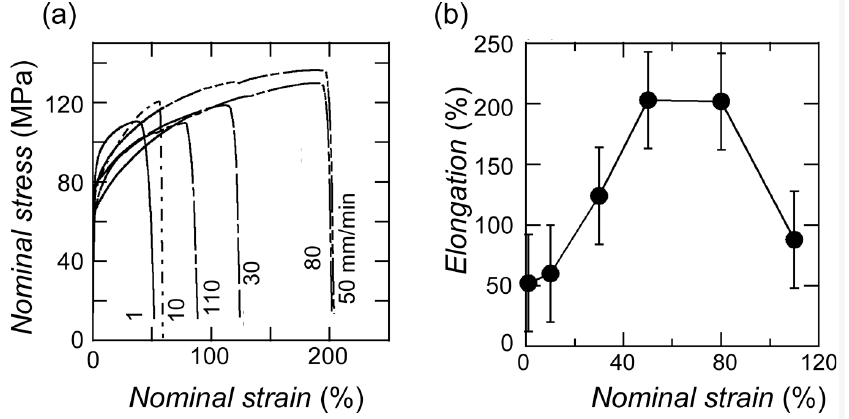
Figure 4. ( a ) Stress–strain curves of Pt fiber A- µ -PD at various growth rates. ( b ) Growth rate dependence of breaking elongation for Pt fiber A- μ -PD .